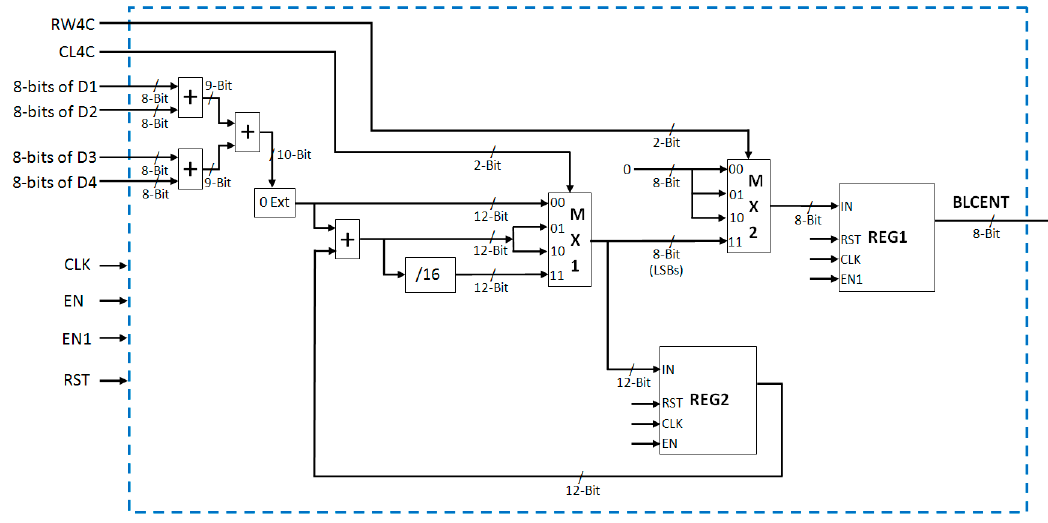
Figure 13. Proposed VLSI architecture for block centroid computation module.